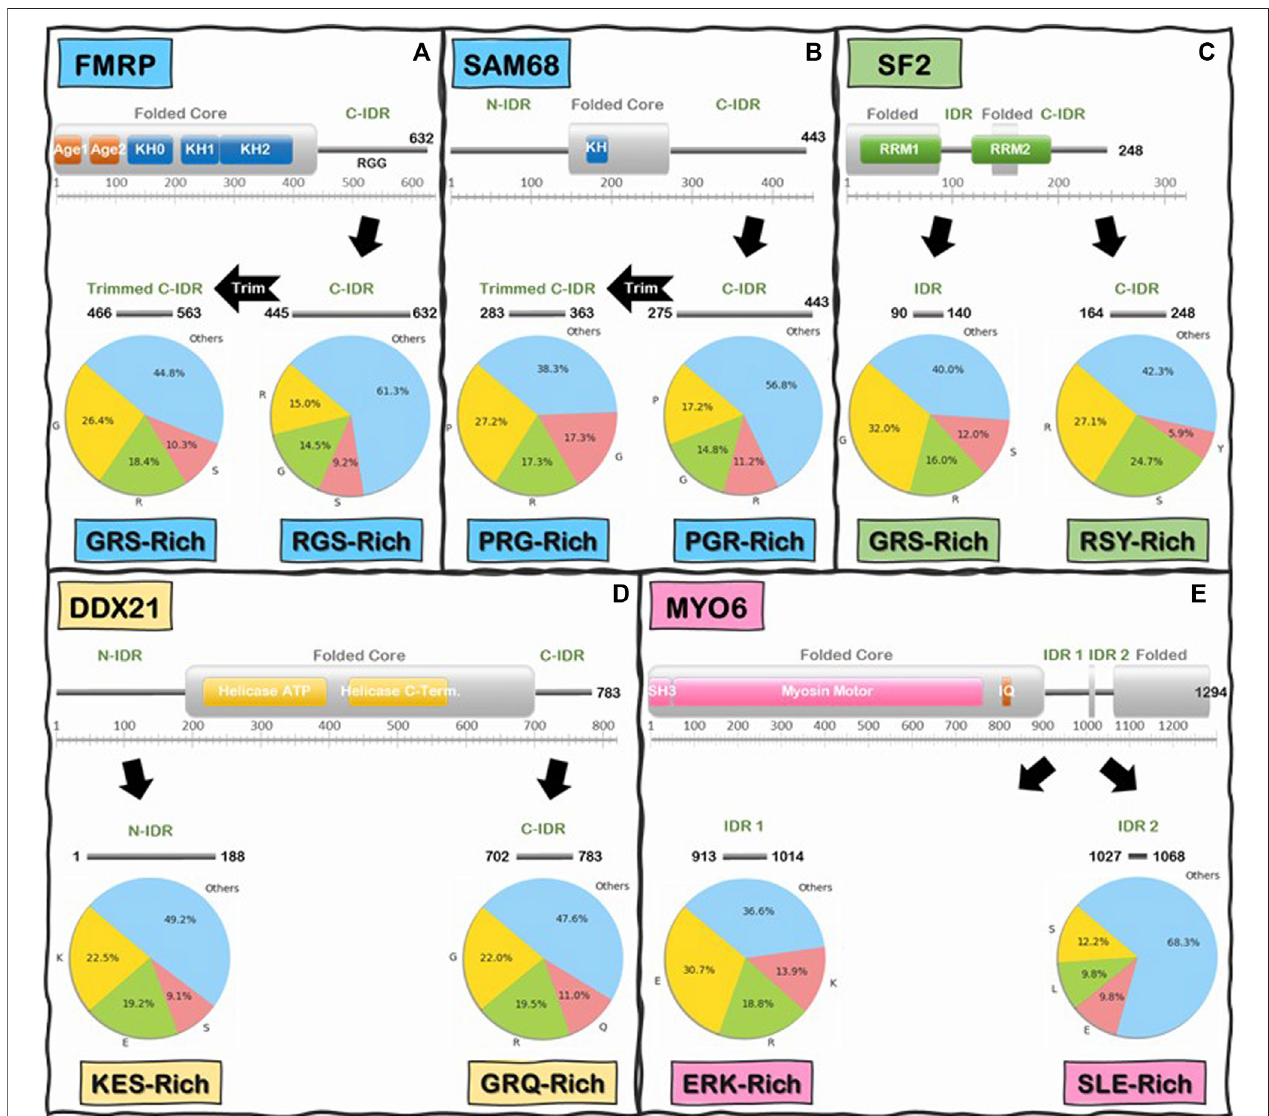
FIGURE 6 | Schematics oflow-complexity sequence in the IDRs of Readers and Enzymes of the R-loop Interactome. First and last residue number for each IDR is indicatedalongtheIDRschematics.Piechartsindicatethefrequency(%)ofthethreemostabundantaminoacidsintheIDRabove,andtheremaining17aminoacidsare grouped into “ Others ” . Boxes underneath pie charts indicate, in decreasing order, the three most abundant amino acids in the IDRs above. (A) FMRP C-IDR ’ s RGS residues make up to 38.7% of the entire IDR, while this content increases to 55.2% in the subregion from residue 466 to residue 563. (B) SAM68 C-IDR ’ s PGR residuesmakeupto43.2%oftheentireIDR,whilethiscontentincreasesto61.7%inthesubregionfromresidue283toresidue363. (C) SF2internalIDR ’ sGRSresidues make upto60%oftheentireIDR contentwhile C-IDR ’ sRSYresidues makeupto57.7%oftheentireIDRcontent. (D) DDX21N-IDR ’ sKES residues makeupto50.8% of the entire IDR content while C-IDR ’ s GRQ residues make up to 52.4% of the entire IDR content. (E) MYO6 internal IDR 1 ’ s ERK residues make up to 63.4% of the entire IDR content while internal IDR 2 ’ s SLE residues make up to 31.7% of the entire IDR content. Interestingly, the IDRs of Readers and Enzymes are generally biased towards different